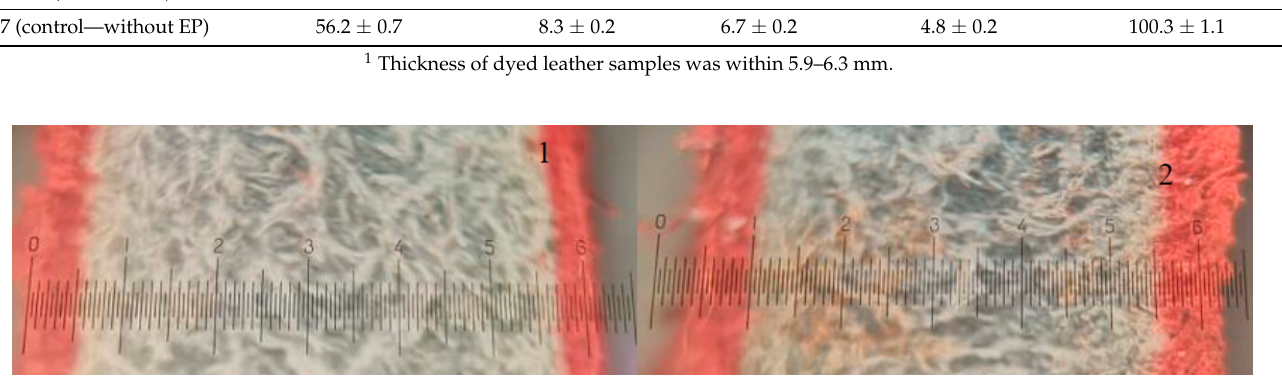
Figure 4. Images of dyed leather cross-section: magnification 15 times. 1 —pickled conventionally; 2 —pickled adding EP Zime SB 3%.